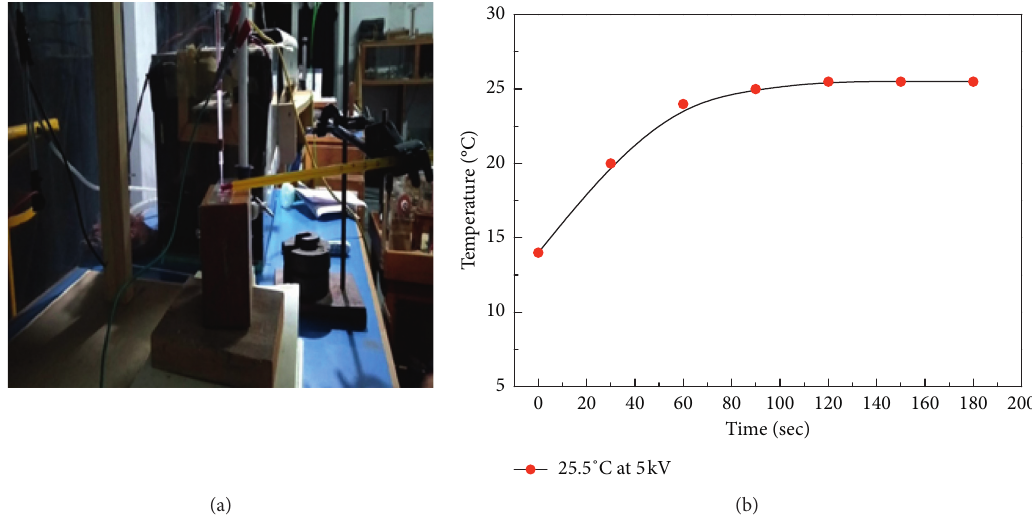
Figure 4: (a) Image of CAPJ during direct temperature measurement using thermometer and (b) variation of temperature of the plasma jet as a function of time (5kV, 19.56kHz, and